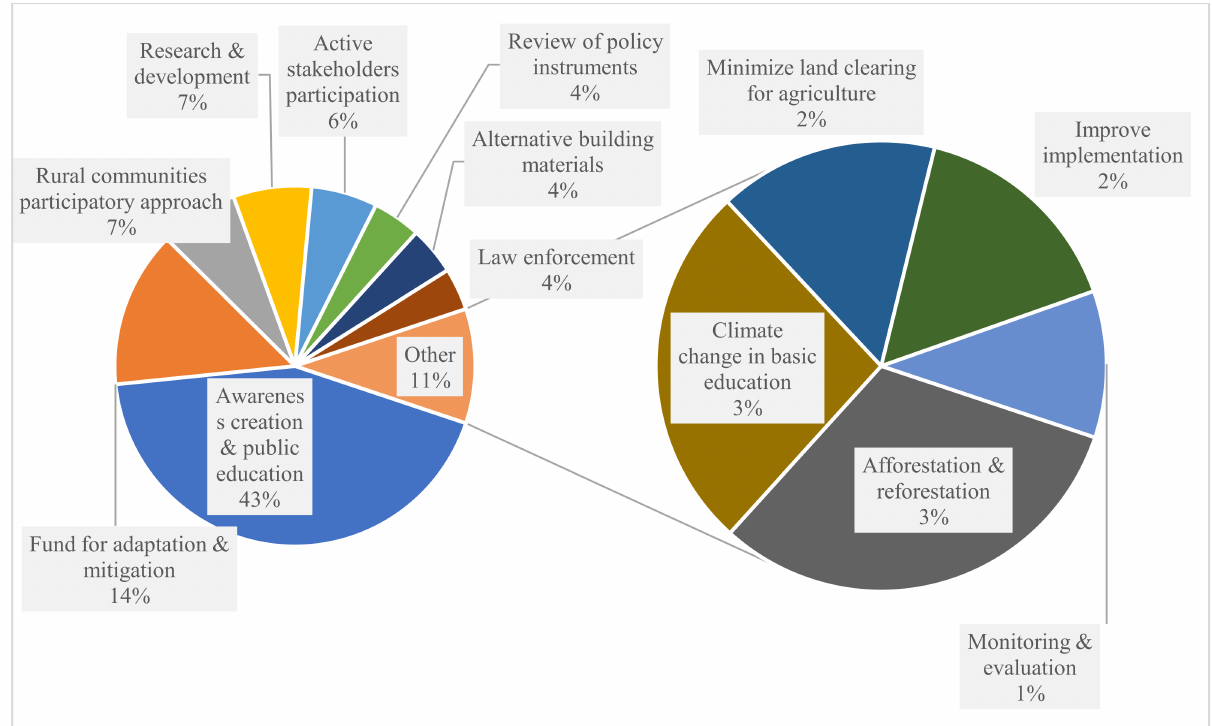
Figure 5. Possible improvements for policy instruments for climate change adaptation in mopane woodlands according to stakeholders from various